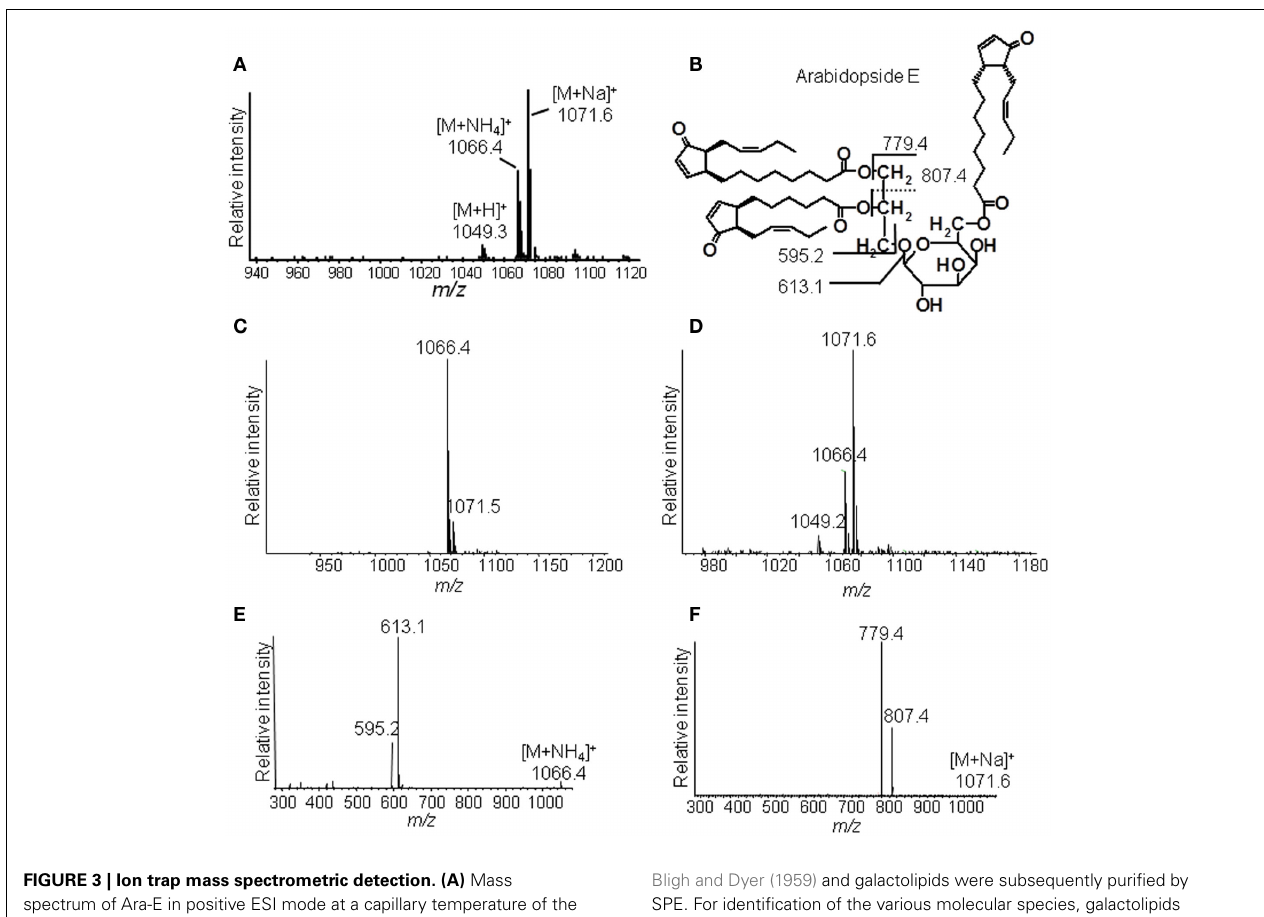
Bligh and Dyer (1959) and galactolipids were subsequently purified by SPE. For identification of the various molecular species, galactolipids were separated by RP-HPLC and then detected in positive ESI mode using an ion trap mass spectrometer.The galactolipid fraction resulting from 200 to 300mg of plant material was used.The ammonium and sodium adducts of the various galactolipid species were detected at the respective capillary temperatures of the ion source in a mass range of 450–1,500amu and at CE of 2V.